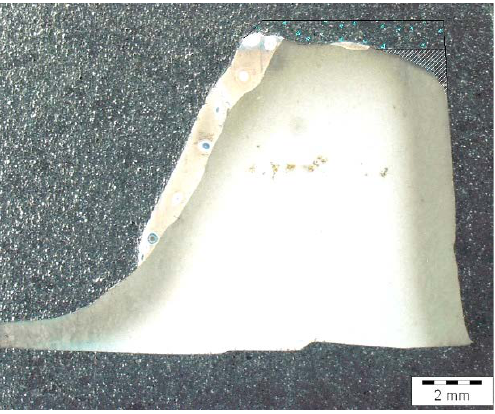
Figure 8. Macroscopic cross-sectional view through the bit tooth, with a reconstruction of the original geometry.